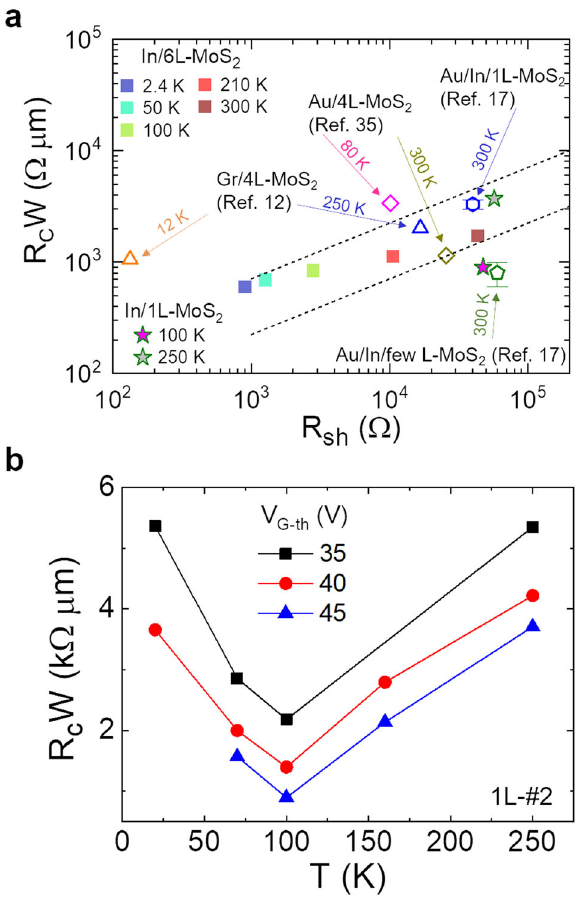
Fig. 7 Contact resistance with sheet resistance at In/MoS 2 contacts. a Minimum R c W as a function R sh of 6L-#1 and 1L-#2 MoS 2 devices at various temperatures (scattered solid squares and stars, respectively) with previous works (opened triangles: graphene (Gr)/4L-MoS 2 , opened diamonds: Au/4L-MoS 2 , opened pentagons: Au/In/few (1) L-MoS 2 ). The upper and lower dashed lines were obtained with ρ c = 5 × 10 − 6 Ω cm 2 and 5 × 10 − 7 Ω cm 2 , respectively. b R c W – T curves for various V G-th conditions of 1L-#2 MoS 2